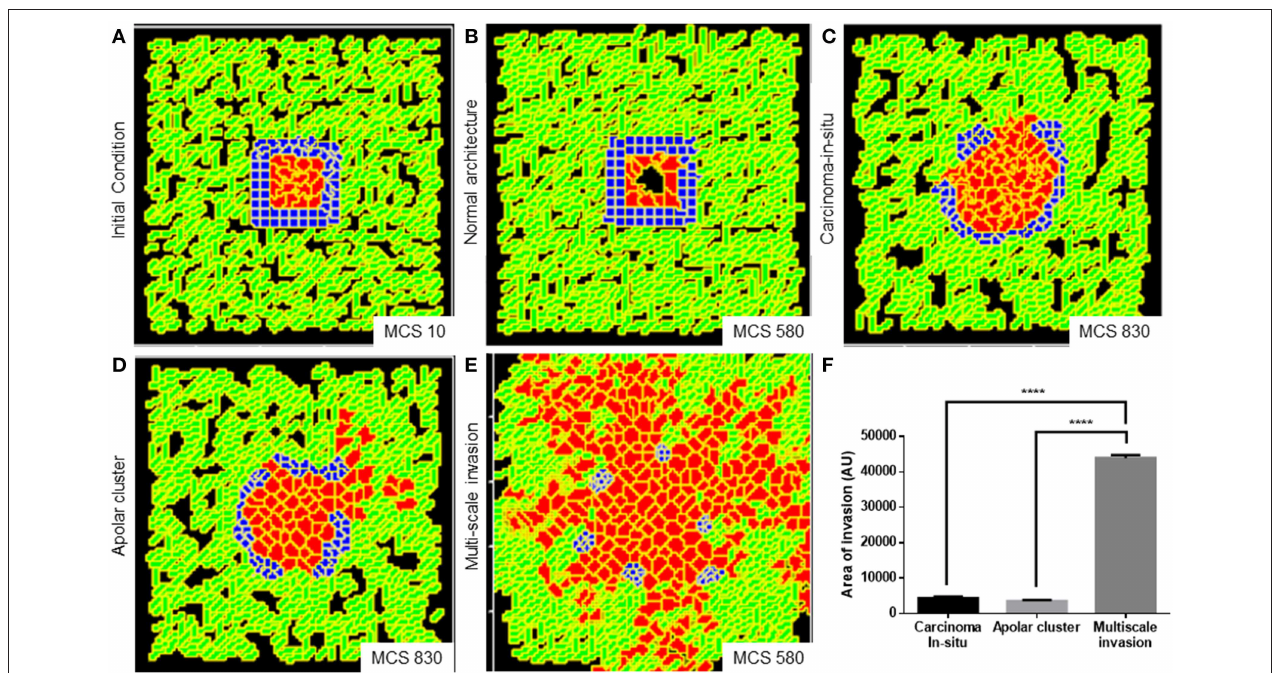
FIGURE 6 | Parameter variation in the computational model can simulate homeostatic, precancerous, and indolently cancerous phenotypes. (A) Initial configuration of all components of the computational model at MCS 0. (B) Simulation of a homeostatic growth-arrested phenotype with a central lumen obtained upon imposing a nonfibrillar ECM-based rules for regulation of cellular quiescence and death of anchored and detached cells, respectively. (C) Simulation of a carcinoma in situ -like phenotype obtained by maintaining high values of cell–cell and cell–nonfibrillar ECM adhesion. (D) Decreasing cell–cell and cell–ECM adhesion in simulation leads to a phenotype that shows further loss of polarity (as evidenced by a roughness in the outer contour of the clusters) and occasional subinvasive single cell phenotypes. (E) Further decreasing cell–cell and cell–matrix adhesion and deployment of an R-D-based kinetics of ECM remodeling leads to multiscale invasion. (F) Quantification (bottom right) of the invasiveness of cells from simulations of homeostasis, carcinoma in situ , apolar clusters, and multiscale invasion. Scale bar: 100 µ m. Each bar represents mean ± SEM. **** p <